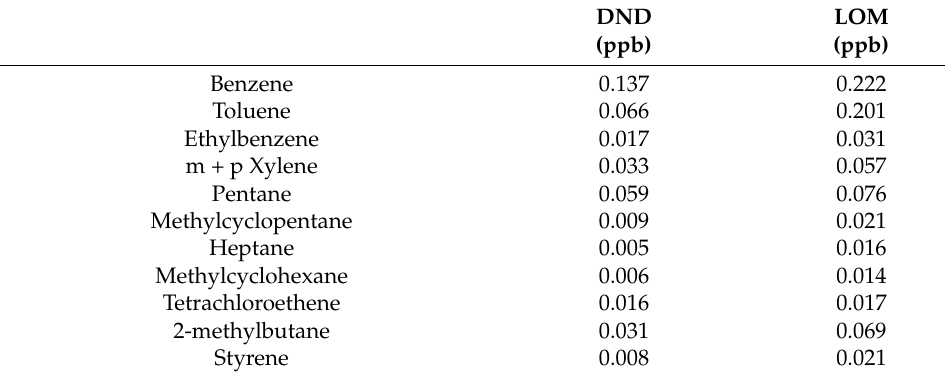
Table 3. Mean concentrations of VOCs at DND and